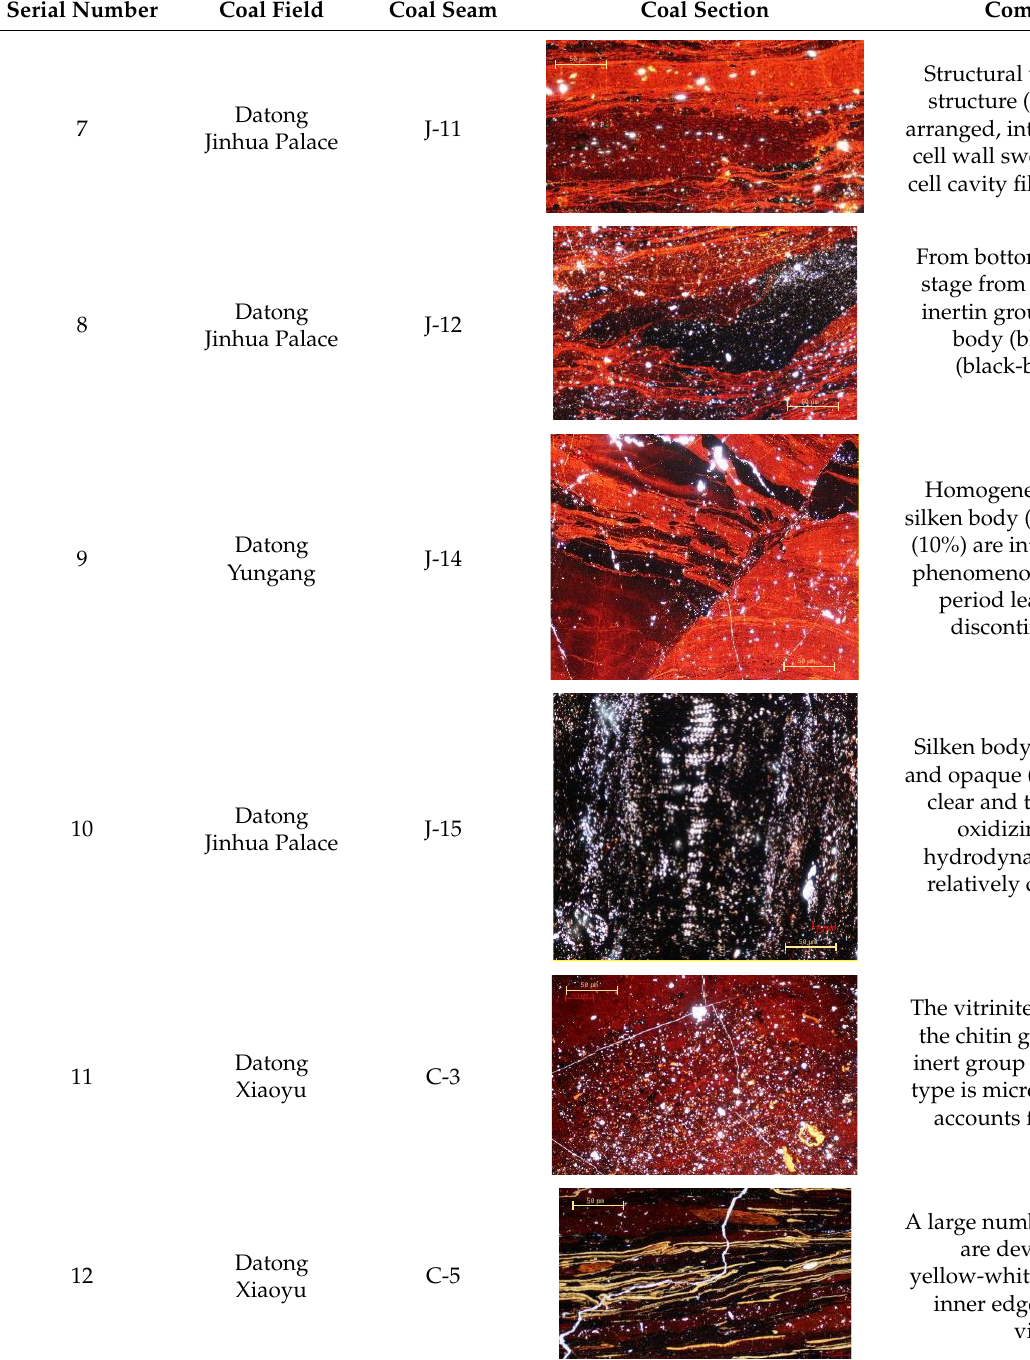
black-brown is semi-silky (45%), and the brown is vitrinite (35%); The cell cavity of the semi-fila- ment body is hollow and the ori- entation is not obvious. entation is not obvious. Component Analysis Structural vitrinites (60%), the Structural vitrinites (60%), the cell structure (40%) is obvious, Structural vitrinites (60%), the cell cell structure (40%) is obvious, neatly arranged, into a honey- structure (40%) is obvious, neatly neatly arranged, into a honey- arranged, into a honeycomb shape, as comb shape, as cell wall swells comb shape, as cell wall swells cell wall swells absorbing water and absorbing water and cell cavity absorbing water and cell cavity cell cavity filled with matrix vitrinite. filled with matrix vitrinite. filled with matrix vitrinite. From bottom to top is the transi- From bottom to top is the transi- From bottom to top is the transition tion stage from vitrinite group tion stage from vitrinite group stage from vitrinite group (60%) to (60%) to inertin group (40%), inertin group (40%), which are silk (60%) to inertin group (40%), body (black), semi-silk body which are silk body (black), semi- which are silk body (black), semi- (black-brown), and vitrinite silk body (black-brown), and vit- silk body (black-brown), and vit- (red-brown). rinite (red-brown). rinite (red-brown). Homogeneous vitrinite (60%) and silken body (30%), semi-filament body (10%) are interlayered as a transition phenomenon, and cracks in the later period lead to the bending and discontinuity of the laminae. Silken body (30%), cell wall as black and opaque (70%); the cell structure is clear and the cavity is hollow. An oxidizing environ- ment and hydrodynamic force is weak, with relatively complete biological cell structure. The vitrinite group accounts for 70%, the chitin group is for 20%, and the inert group is for 10%. coal, and vitrinite accounts for the most important component. A large number of keratinocytes (30%) are developed in yellow or yellow-white thin strips, with jag- ged inner edges, often inlaid around vitrinites (70%). Vitrinite occupies 55%, inertite occupies 45%, and the coal rock type is micromirror inert coal; structure of vitrinite is filledin in- ertite as massive or linear. Algae body (left), yellow 30%; silken body (right), black, opaque, hollow, visible cell struc- ture 40%, but part of cell wall is swollen 30%; red is the mass vit- rinite; yellow and orange mega- spores (lower) are distributed along the layer.